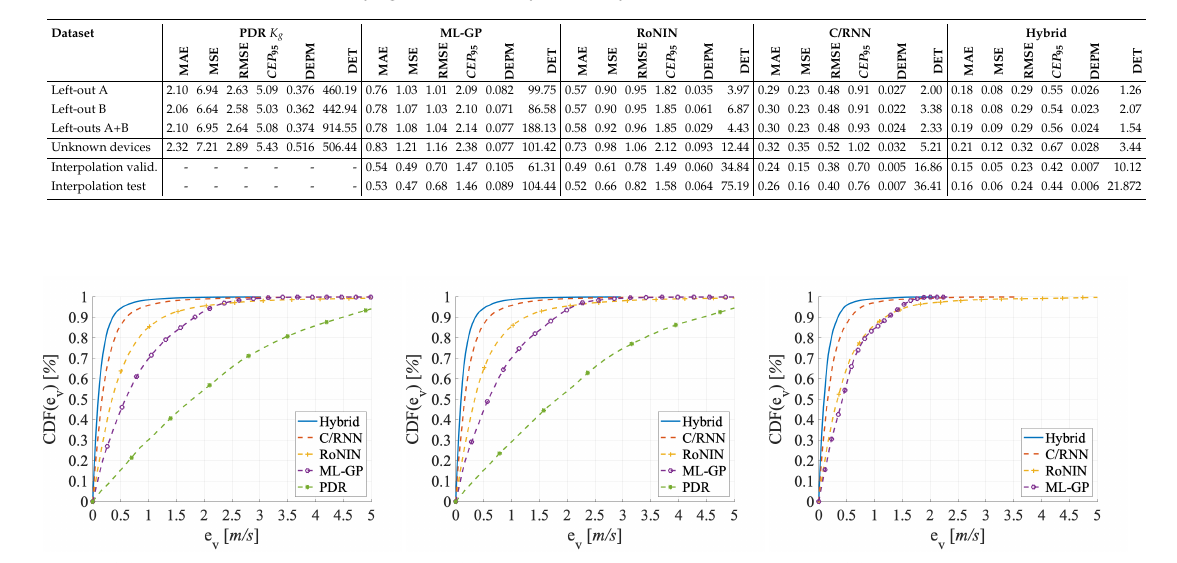
Table 4. Accuracy; generalizability; velocity errors in m/s; distance errors in m.